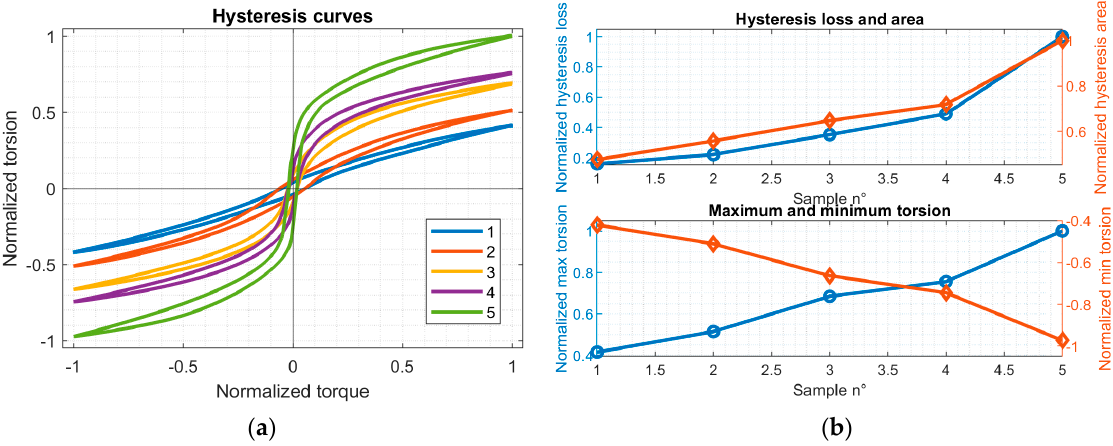
Figure 7. ( a ) Evolution of the hysteresis curve of gear B over time normalized with respect to the measurements in sample 5. ( b ) Trends of the hysteresis loss, area, minimum, and maximum torsion of gear B over time normalized with respect to the measurements in sample 5.